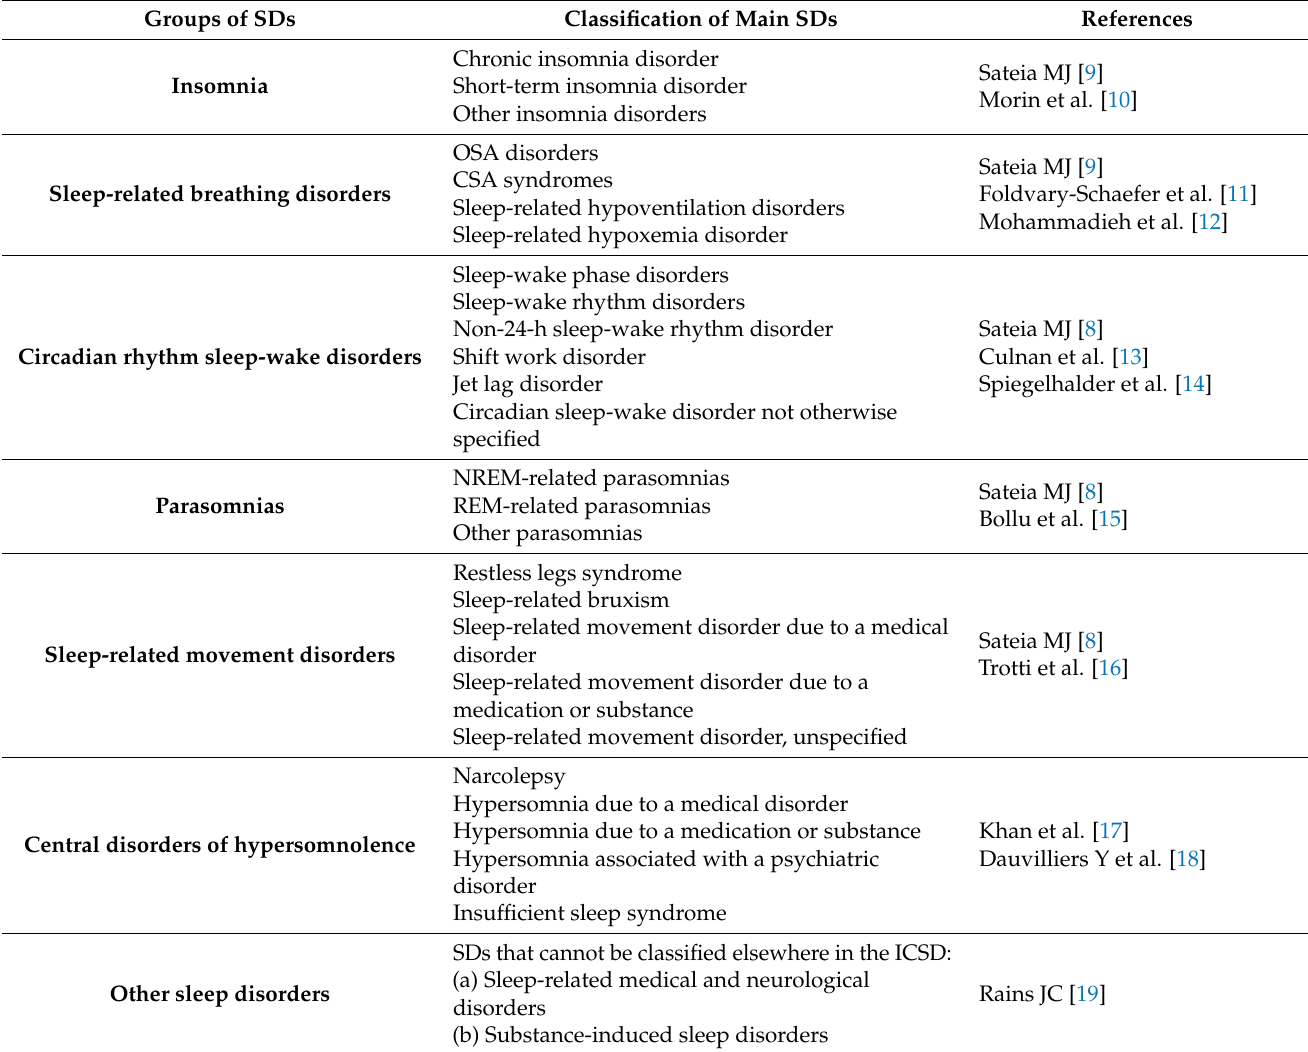
Table 1. Classification of sleep disorders (SDs) according to the International Classification of Sleep Disorders (ICSD) 3rd edition